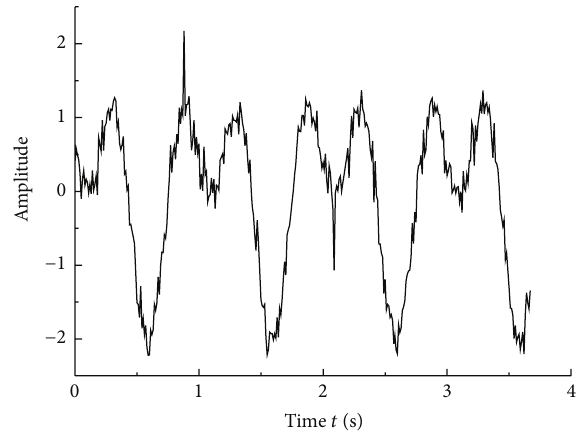
Figure 4: The simulated signal 𝑧(𝑡)